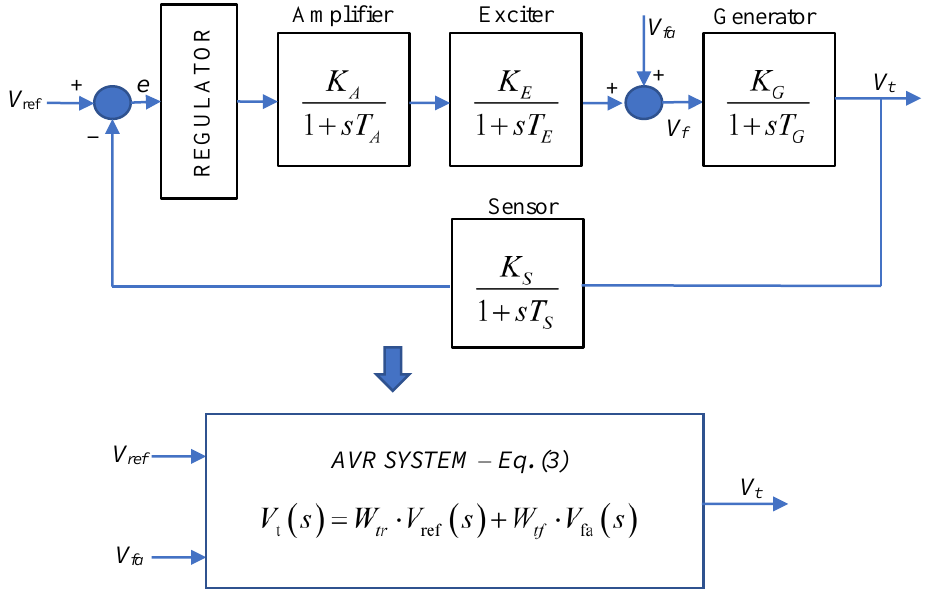
Figure 4. AVR model with two input signals.